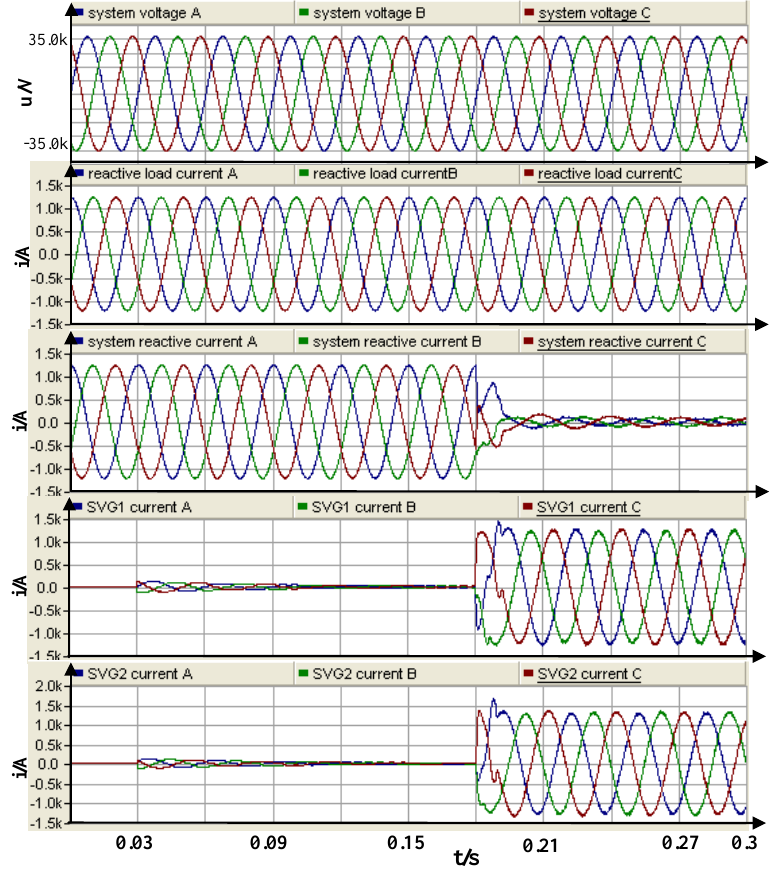
Figure 12. Compensation 35 kV system reactive power.